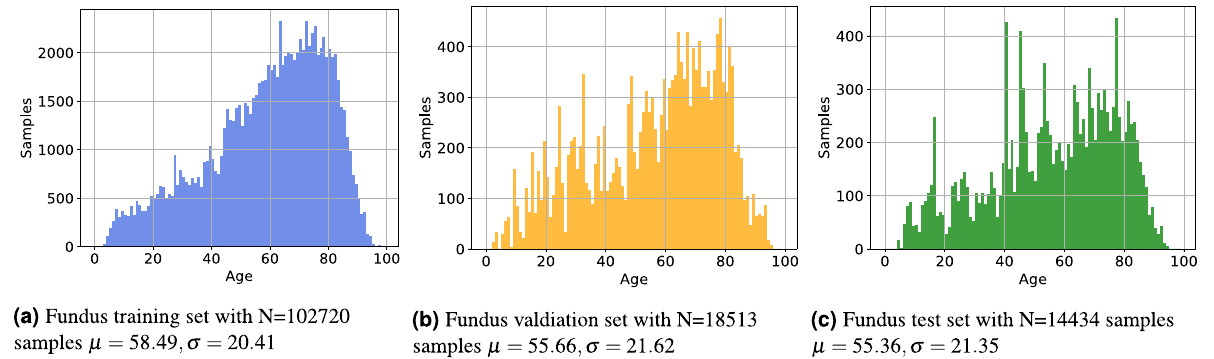
Figure 1. Histogram of patient ages for the corresponding the fundus data sets.